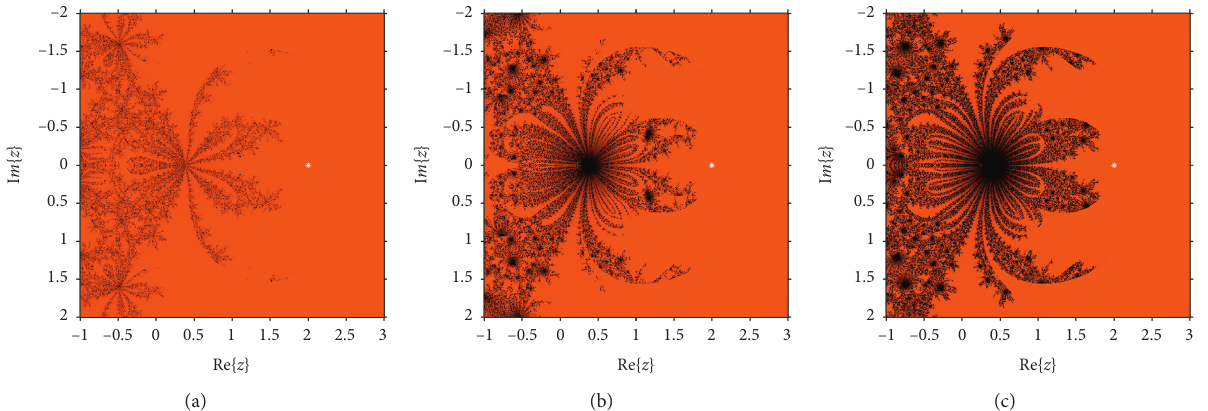
Figure 5: Basins of attraction of (a) BM1, (b) AM2, and (c) ZM3 for g